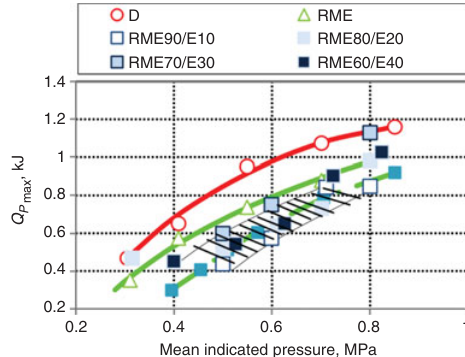
Fig. 5. Q P max behaviour of transferred engine from D to biodiesels